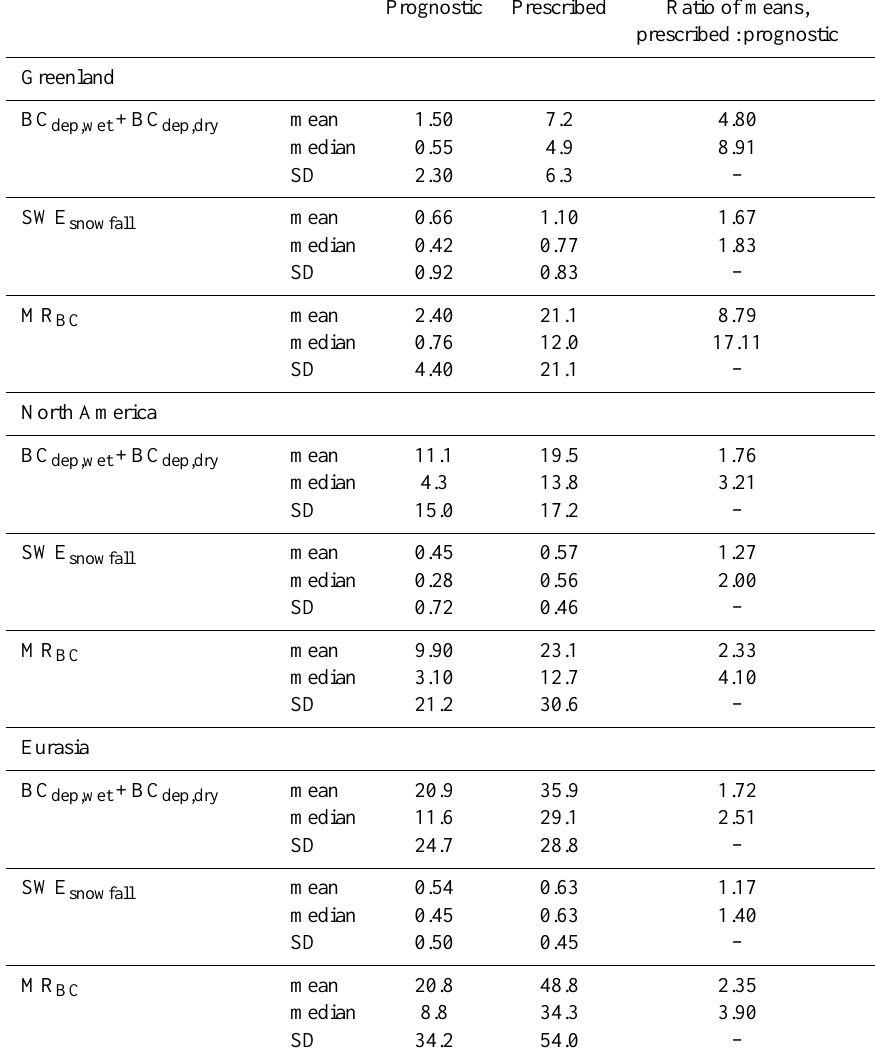
Table 2. Annual means, medians and standard deviations (SDs) of monthly-average BC mass deposition (ngm − 2 day − 1 ), snowfall in snow- prognostic-aerosol and prescribed-aerosol model runs. Also shown are the ratios of the means and medians of each.